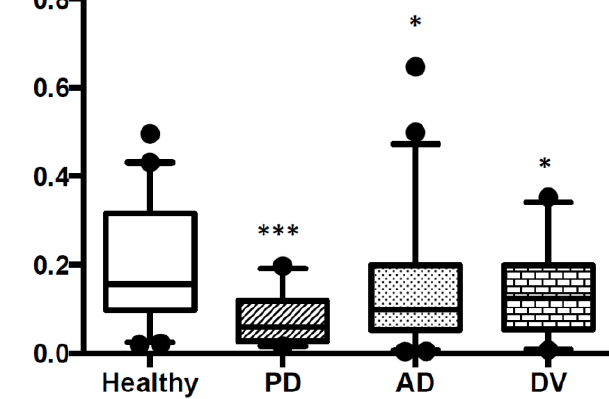
Figure 1. 5hmC levels in blood DNA samples from healthy subjects and patients with AD, PD or DV. Levels of DNA global hydroxymethylation were assayed with an ELISA-like colorimetric assay as described in the Material and Methods. The study includes 47 patients with AD, 30 with PD, 21 with DV and 40 healthy controls. Results are shown in a box-plot graphic. Significance of analysis of variance (ANOVA) and Bonferroni post-test among the indicated groups is shown as * p < 0.05 and *** p <